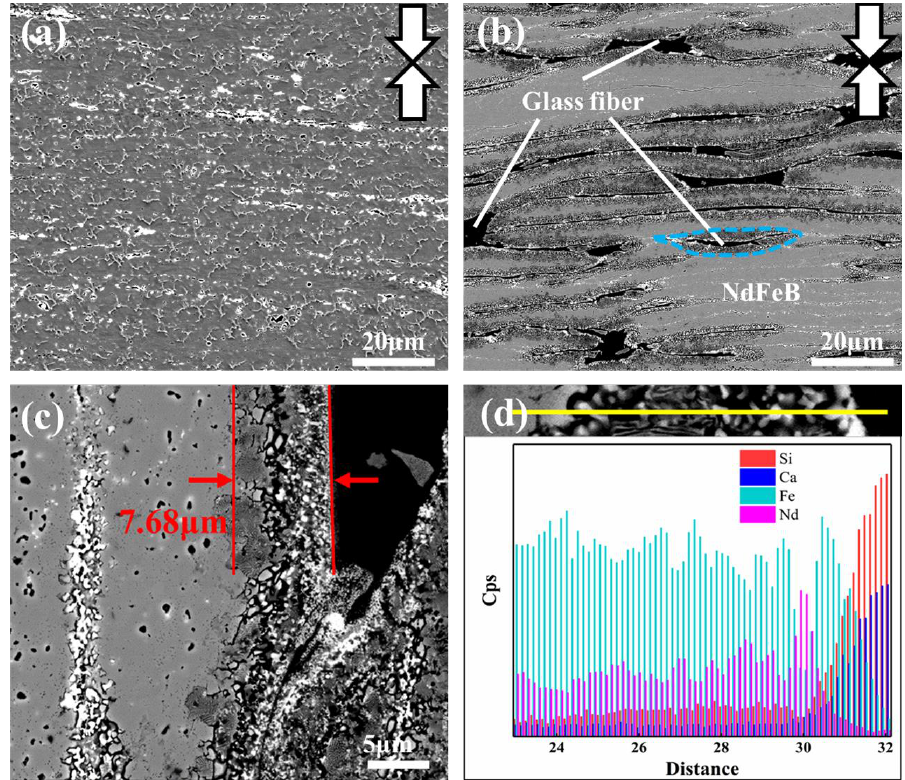
Figure 6. SEM image of hot-deformed magnets, ( a ) without glass fiber, ( b ) with 5wt% glass fiber; ( c ) partial enlarged drawing of ( b , d ) EDS line scanning near the transition layer.